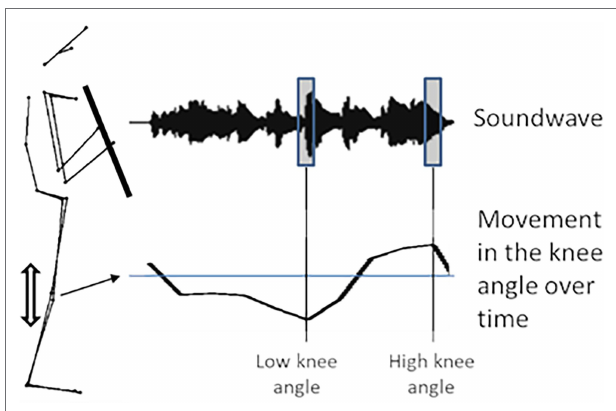
FIGURE 4 | Schematic of the multimodal analysis of motion peaks with sound parameters by the example of the knee